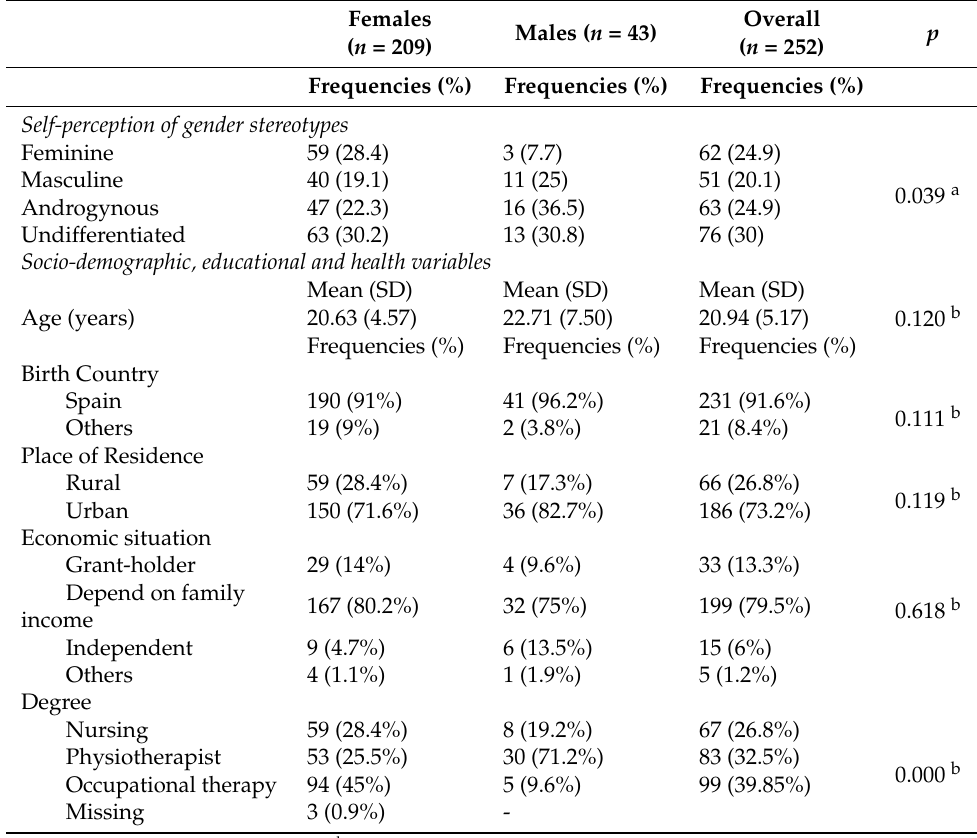
Table 4. Self-perception of gender stereotypes (distribution in instrumental/expressive-type cate- gories) and characteristics per gender in Health Sciences